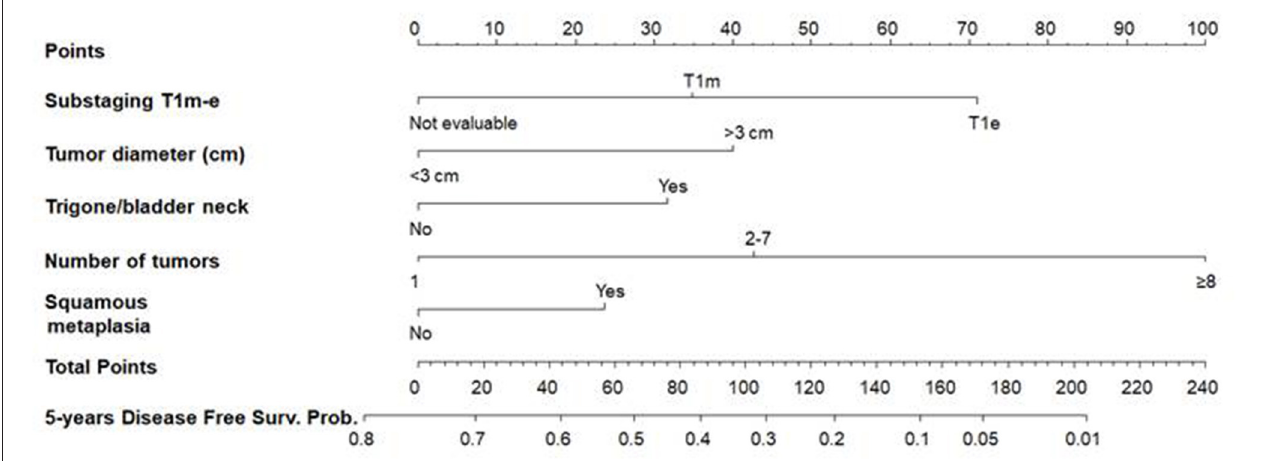
FIGURE 3 | Nomogram 1 for the calculation of the recurrence-free survival (RFS) at 5 years. On the basis of the estimated Cox regression model, patients with T1e (71 points), a > 3cm tumor diameter (40 points), trigone or bladder neck location (32 points), with a number of tumors ≥ 8 (100 points), and presence of squamous metaplasia (24) had a total score of 267, which corresponds to a low 5-year RFS probability ( p < 0.01).